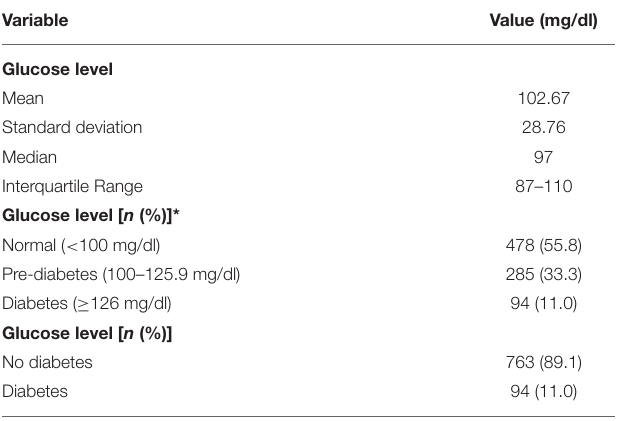
TABLE 1 | Distribution of blood glucose level among study